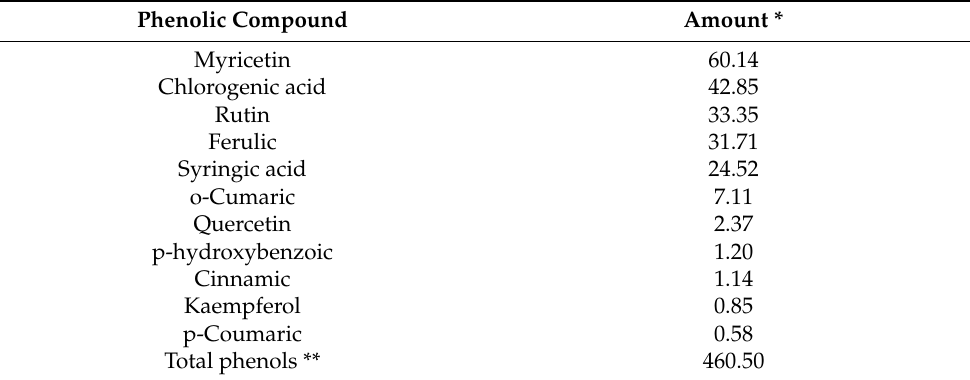
Table 1. Phenolic compounds and total phenols of corn silk